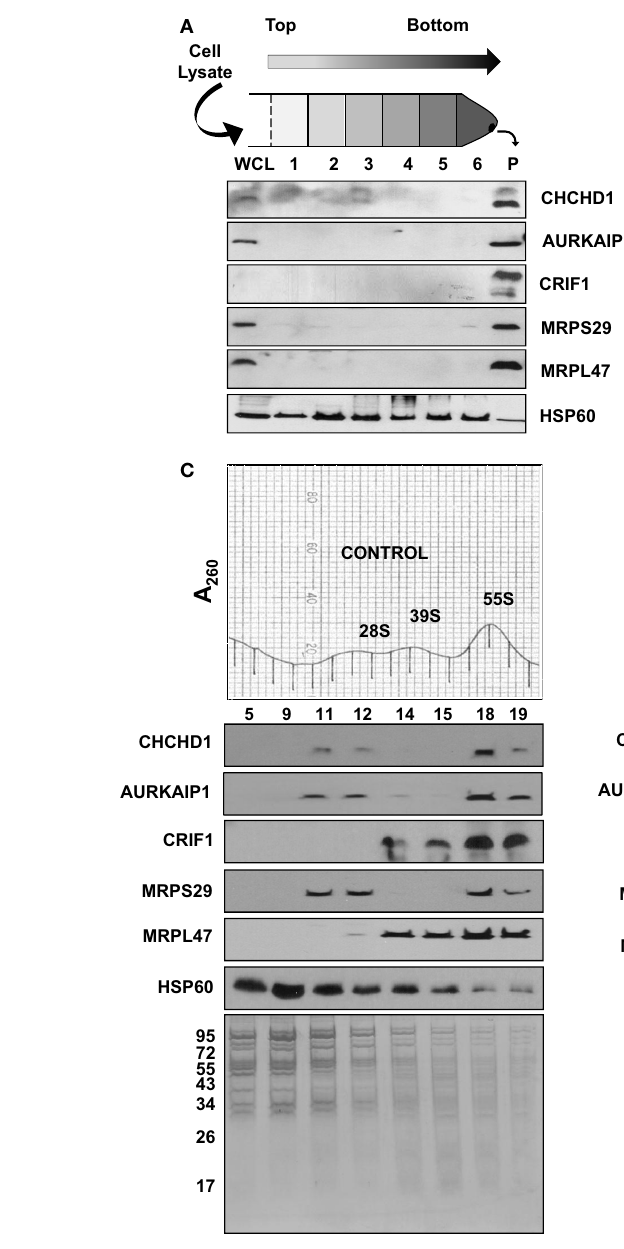
same amount of crude ribosomes, both Control and RNase A-treated, were sedimentedon 10–30%sucrose gradients. Equalvolumesof sucrose gradient fractions were separated on 12% SDS-PAGE. Sedimentation of new MRPs with ribosomal subunits and 55S ribosomes in the absence and presence of RNase A was analyzed by immunoblottingusing CHCHD1, AURKAIP1, CRIF1, MRPS29,andMRPL47antibodies.HSP60immunoblottingandtheCoomassie Bluestainedgelare shownascontrolsfor multimericmitochondrialcomplexes sedimenting with the 55S ribosome in control and RNase A-treated